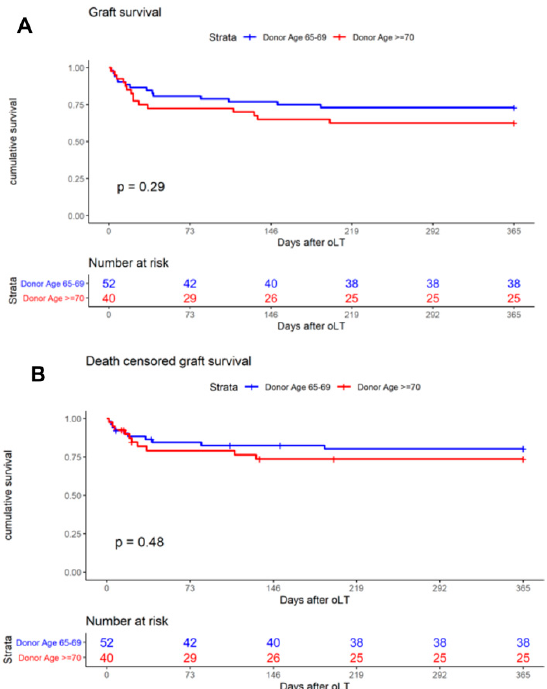
Figure 3. Kaplan–Meier curves demonstrate the impact on one-year graft survival of ( A ) donor age ≥ 65–69 and ≥ 70 years and ( B ) on one-year death-censored graft survival of donor age ≥ 65–69 and ≥ 70 years .